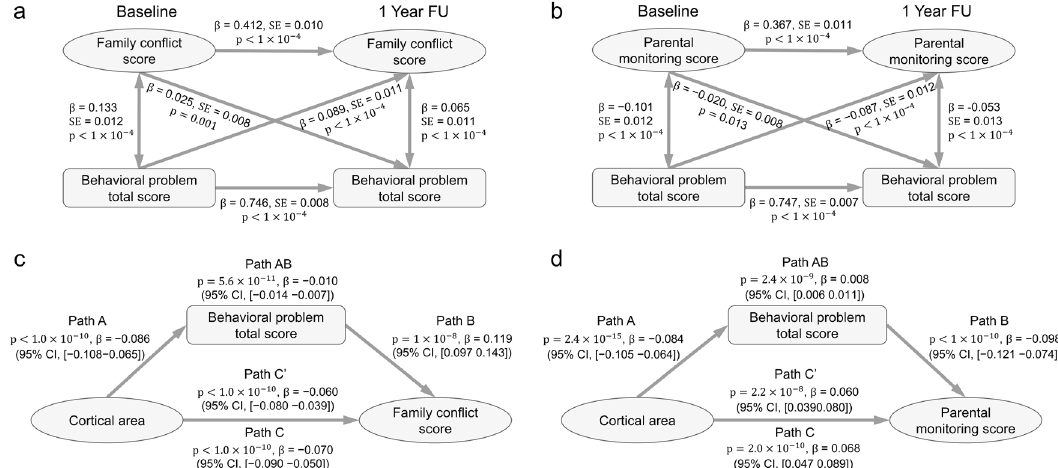
Fig. 3 The longitudinal association and mediation analyses. a The longitudinal association between the behavioral problems total score (TotProb CBCL Syndrome Scale) in the children and the family con fl ict score measured 1 year later using structural equation modeling. Higher behavioral total scores